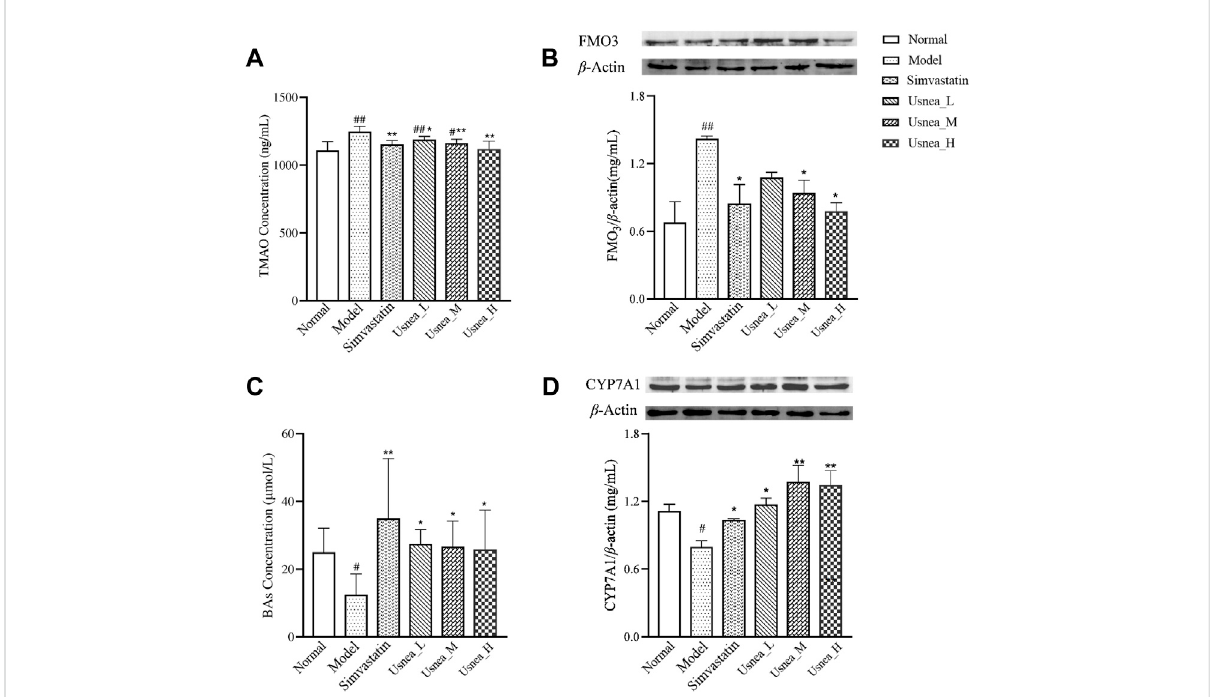
FIGURE 10 UEE affected the control of the metabolic pathways of TMAO and BAs. (A) UEE decreased the concentration of TMAO; (B) UEE inhibited the expression of FMO3; (C) UEE increased the concentration of BAs; and (D) UEE increased the expression of the CYP7A1 protein. Note: Values are expressed as mean ± SD ( n = 6 per group). # p < 0.05, ## p < 0.01 compared with the normal group; * p < 0.05, ** p < 0.01 compared with the model